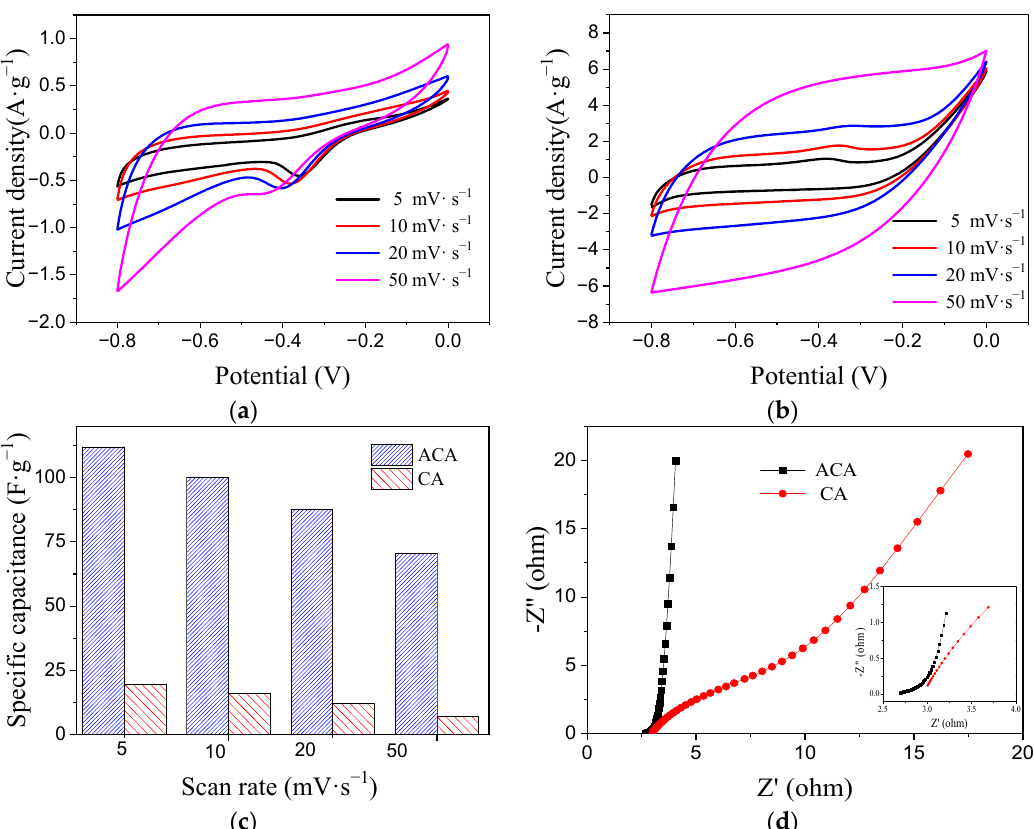
Figure 1. The CV curves of CA ( a ) and ACA ( b ) electrodes at different scan rates, their corresponding specific capacitance ( c ), and AC impedance Nyquist curves ( d ).